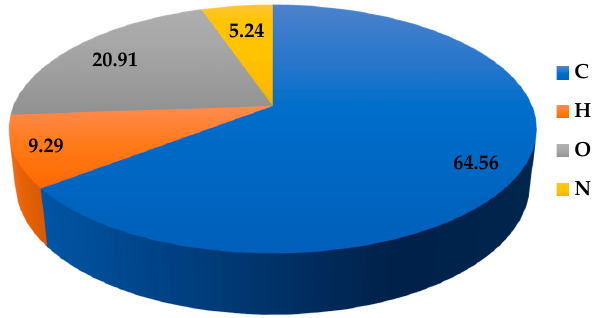
Figure 3. Elemental composition of the Olive pomace using CE-440 Elemental Analyzer.